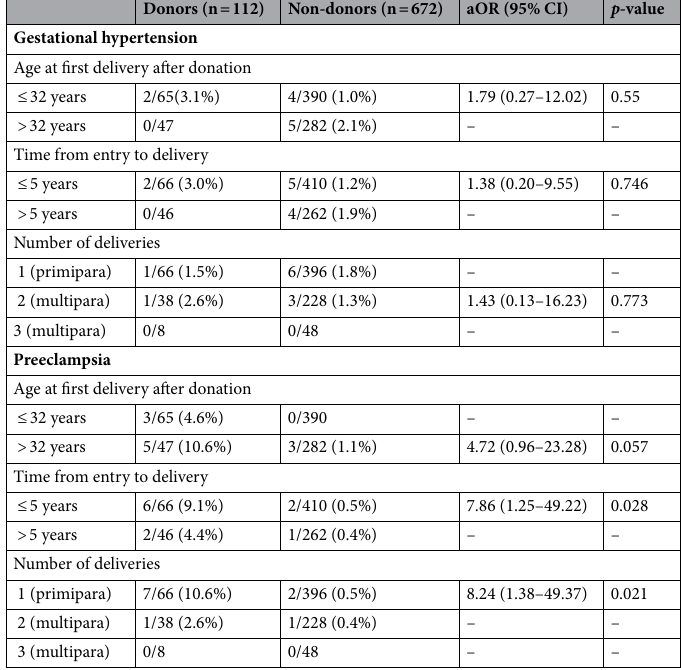
Table 3. Risk factors for gestation hypertension or preeclampsia in living kidney donors. aOR adjusted odds ratio, 95% CI 95% confidence